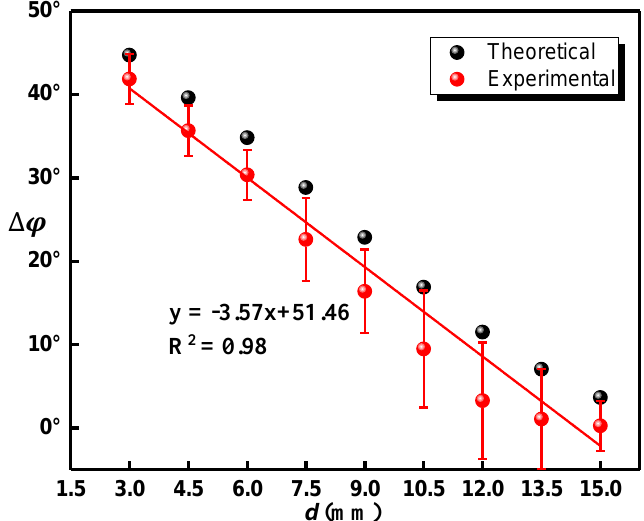
Figure 9. The relationship between the theoretical and experimental phase difference ∆𝜑 and 𝑑 .